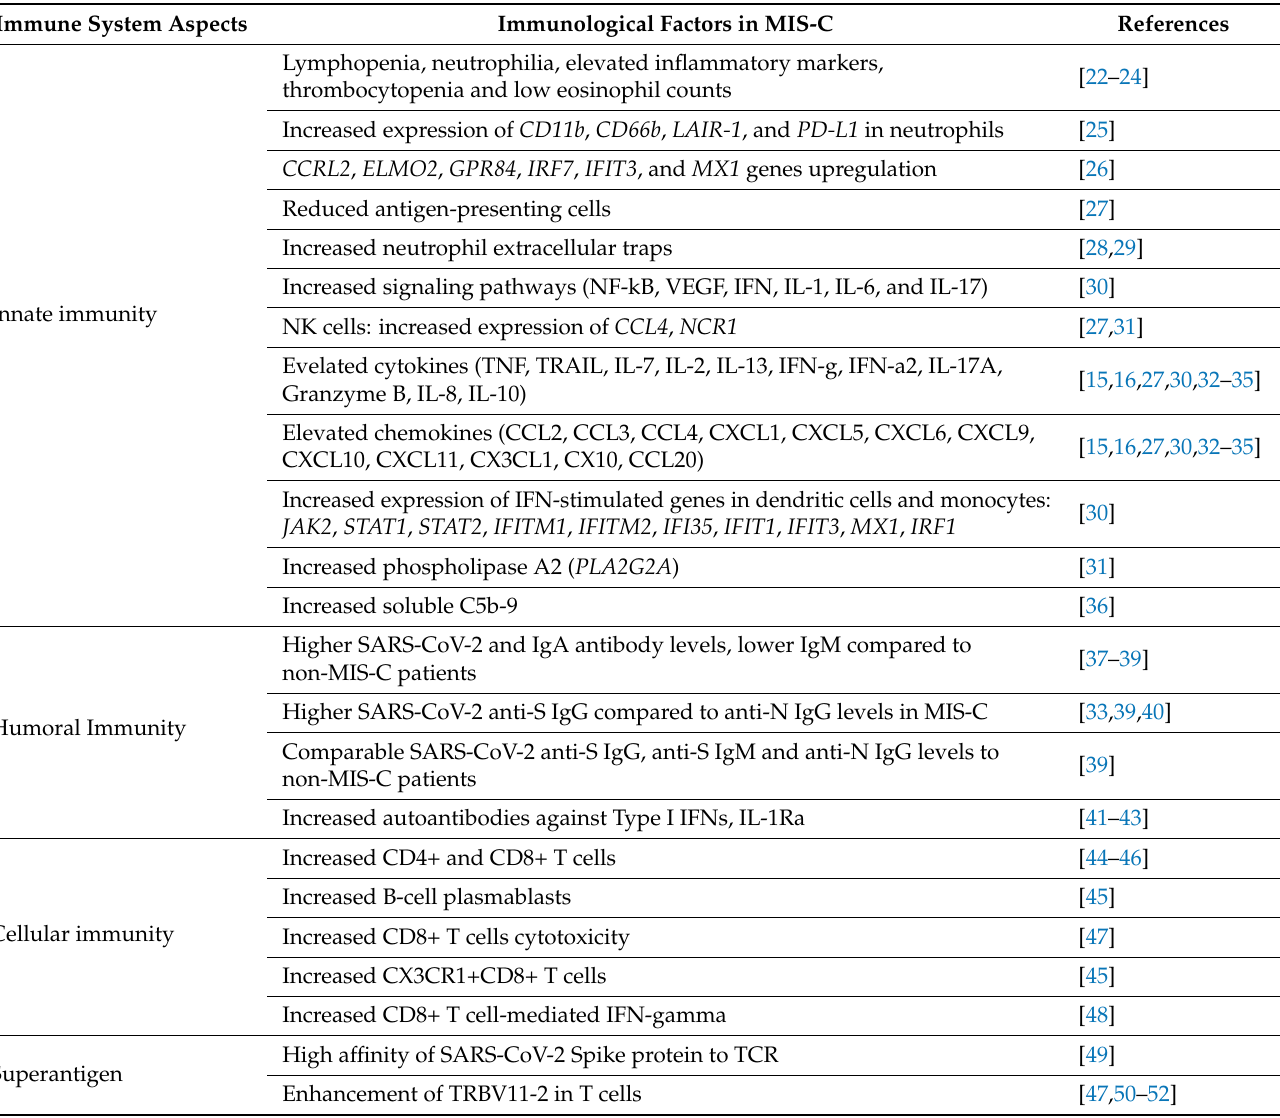
Table 1. Immunological factors associated with MIS-C in innate, humoral and cellular immunity, as well as superantigen hypothesis regarding the syndrome